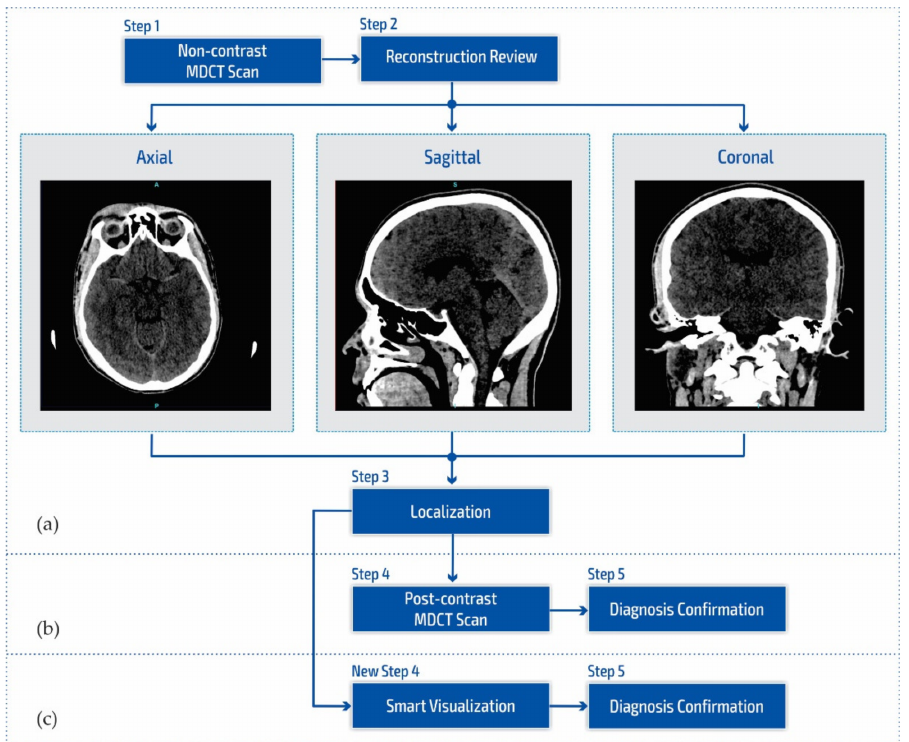
Figure 1. Block diagram of ( a ) the multi-detector computed tomography method, ( b ) the post-contrast MDCT diagnostics method, and ( c ) the smart visualization (SVMI)